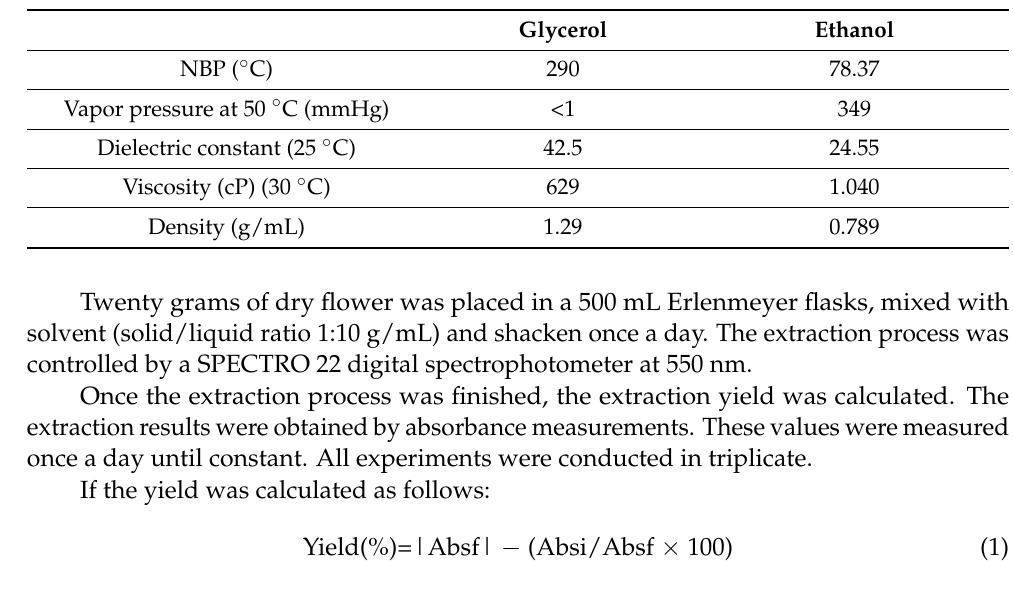
Table 2. Solvent